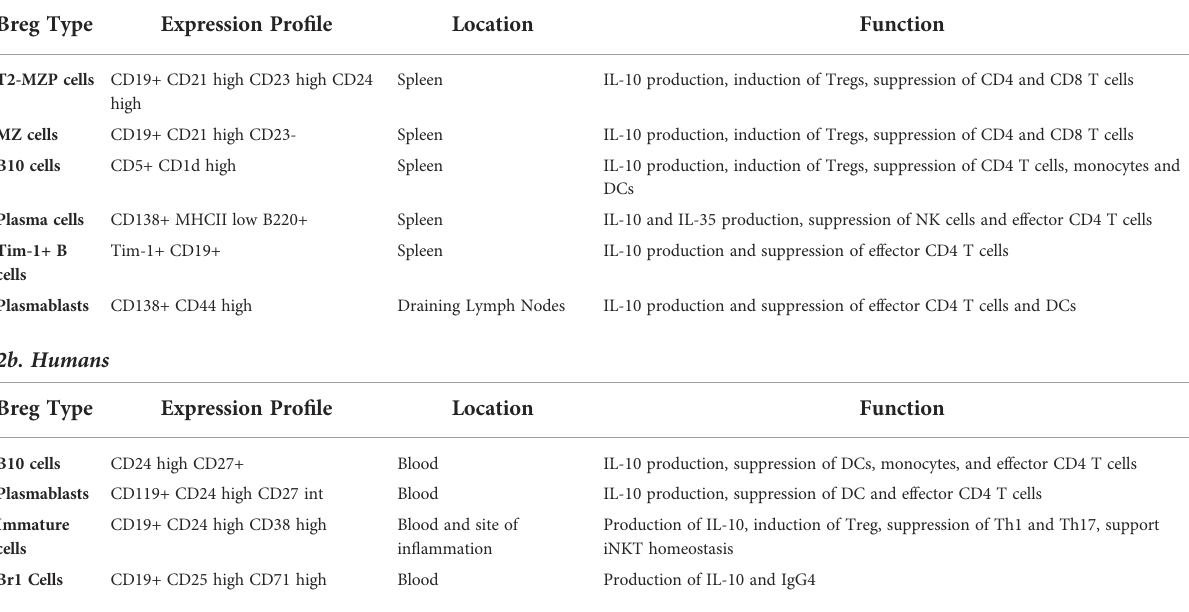
TABLE 2 Expression of cell surface markers in different phenotypes of Breg cells and their function in mice and humans. 2a.